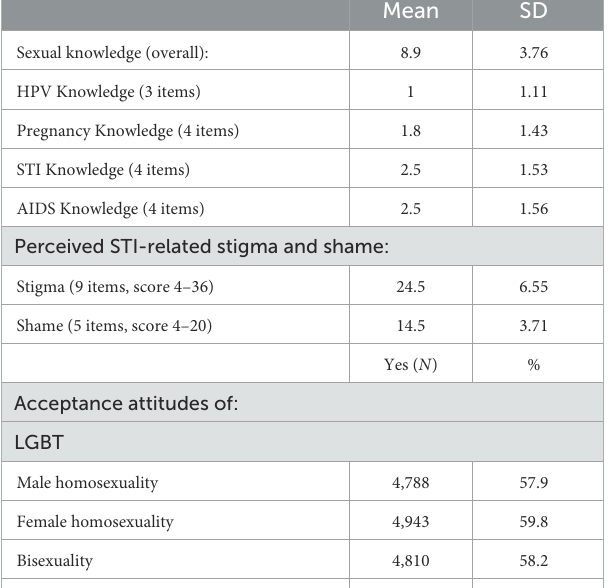
TABLE 2 Sexual knowledge, attitudes, and experience of the